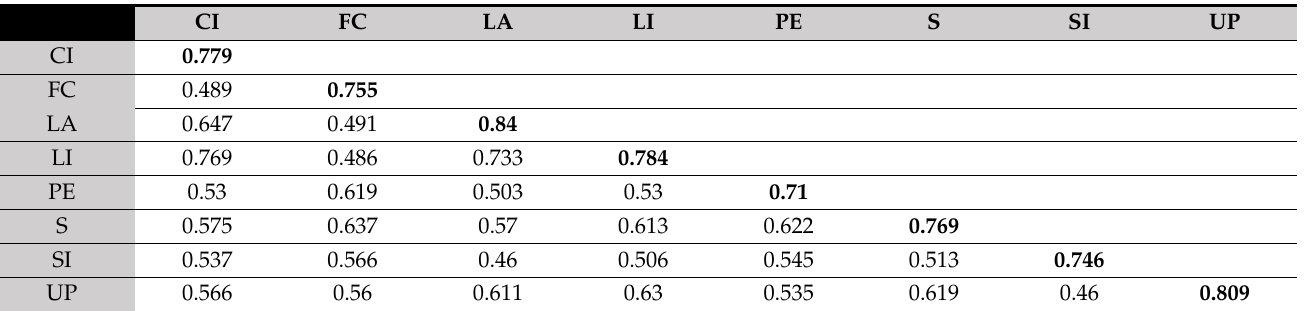
Table 9. Fornell Larcher Criterion.